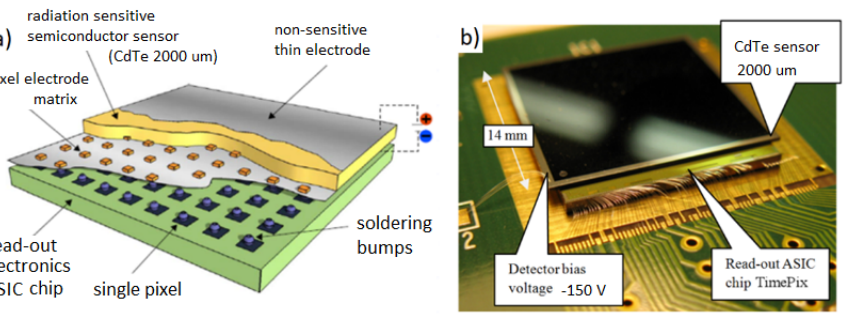
Figure 4. The hybrid semiconductor pixel detector Timepix ( a ) consisting of the Timepix ASIC chip bump-bonded to the radiation sensitive semiconductor sensor (CdTe 2000 µ m thick). The detector radiation sensitive area is 14 mm × 14 mm = 2 cm 2 , shown in ( b